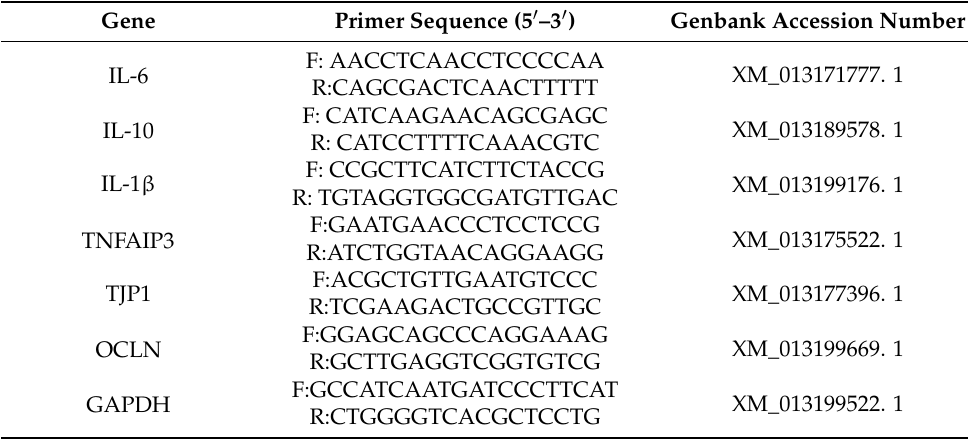
Table 1. The information on the primers used in quantitative